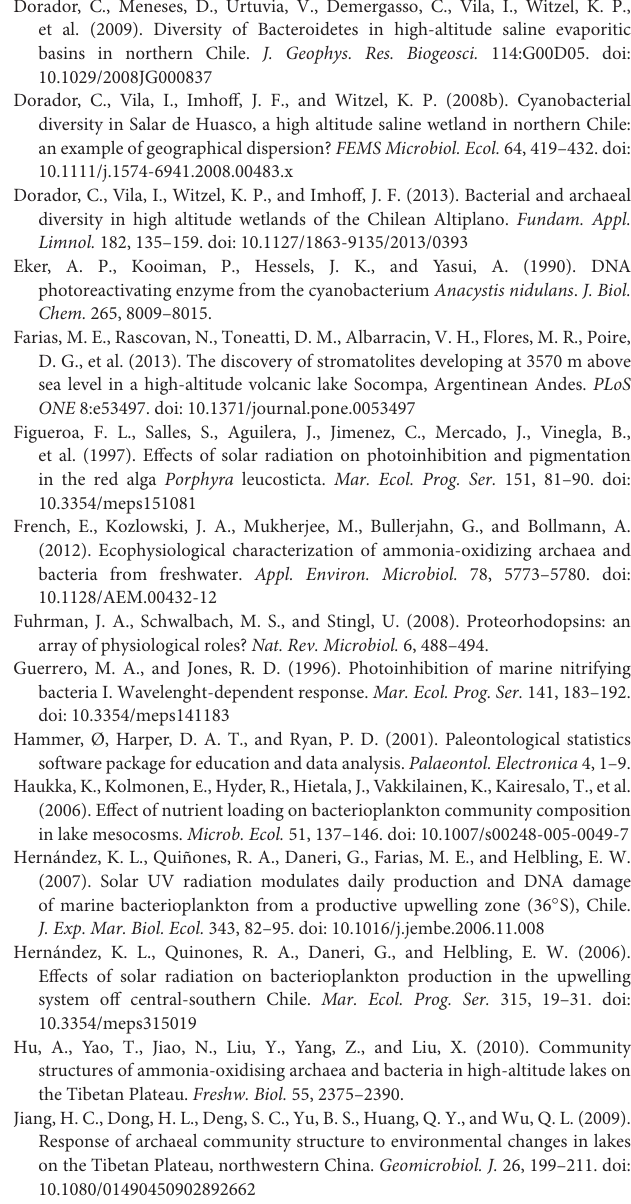
FIGURE S1 | (A) Photographs showing the experiment site and setup and (B) the map of the study area (Salar de Huasco, Chile).